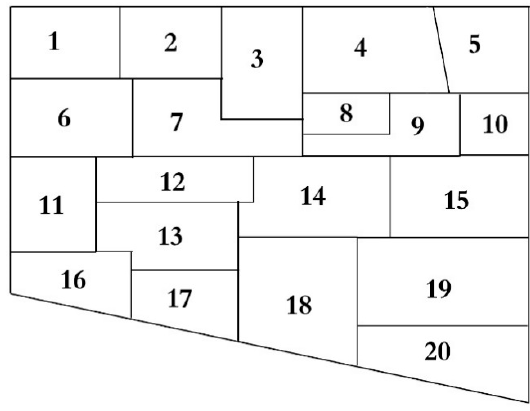
Figure 5. The schematic diagram of 20 regions.